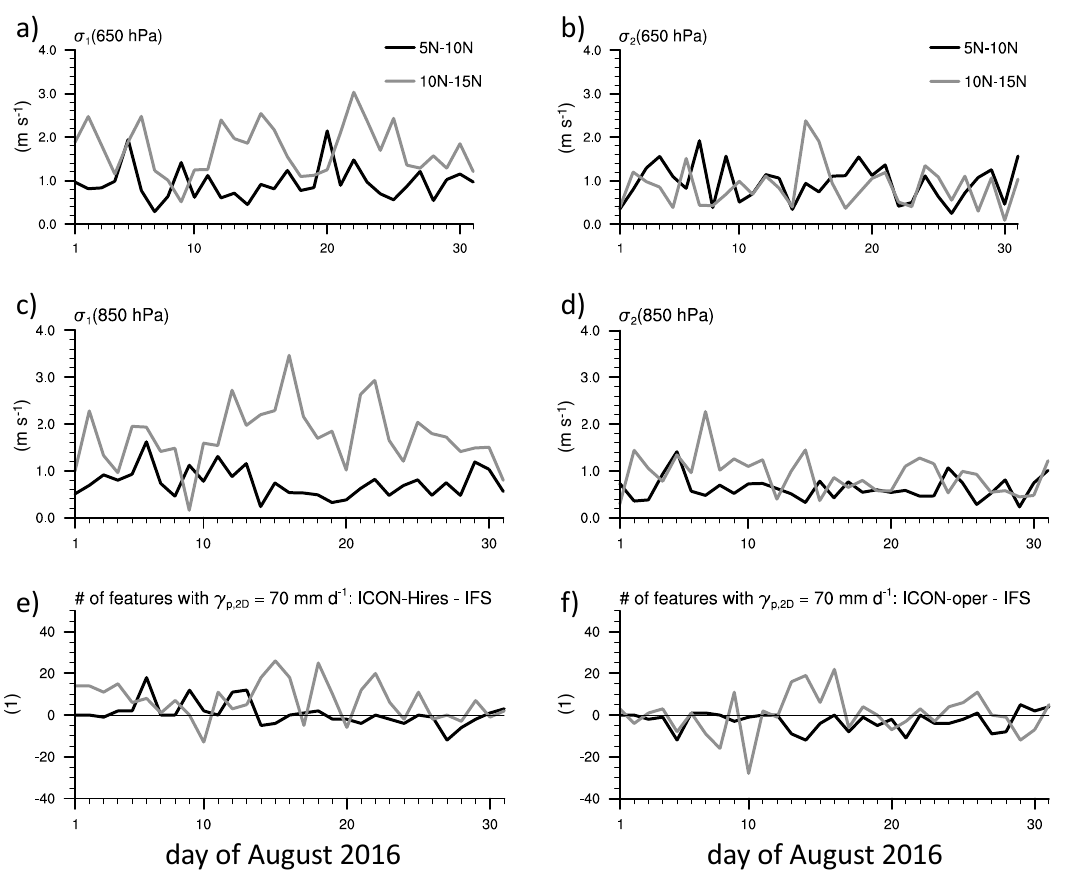
Figure 6. Daily resolved time series (1–31 August 2016) of σ 1,2 (Equation (1)) for wind fields at ( a , b ) 650 hPa and ( c , d ) 850 hPa and ( e , f ) the difference in the number of objectively-identified precipitation features with γ p ,2 D = 70 mm day − 1 between IFS and ICON-HiRes ( c ) (ICON-oper ( f )). Average values of σ 1 ( σ 2 ) and the number of identified features are analyzed over two different subdomains and over land areas